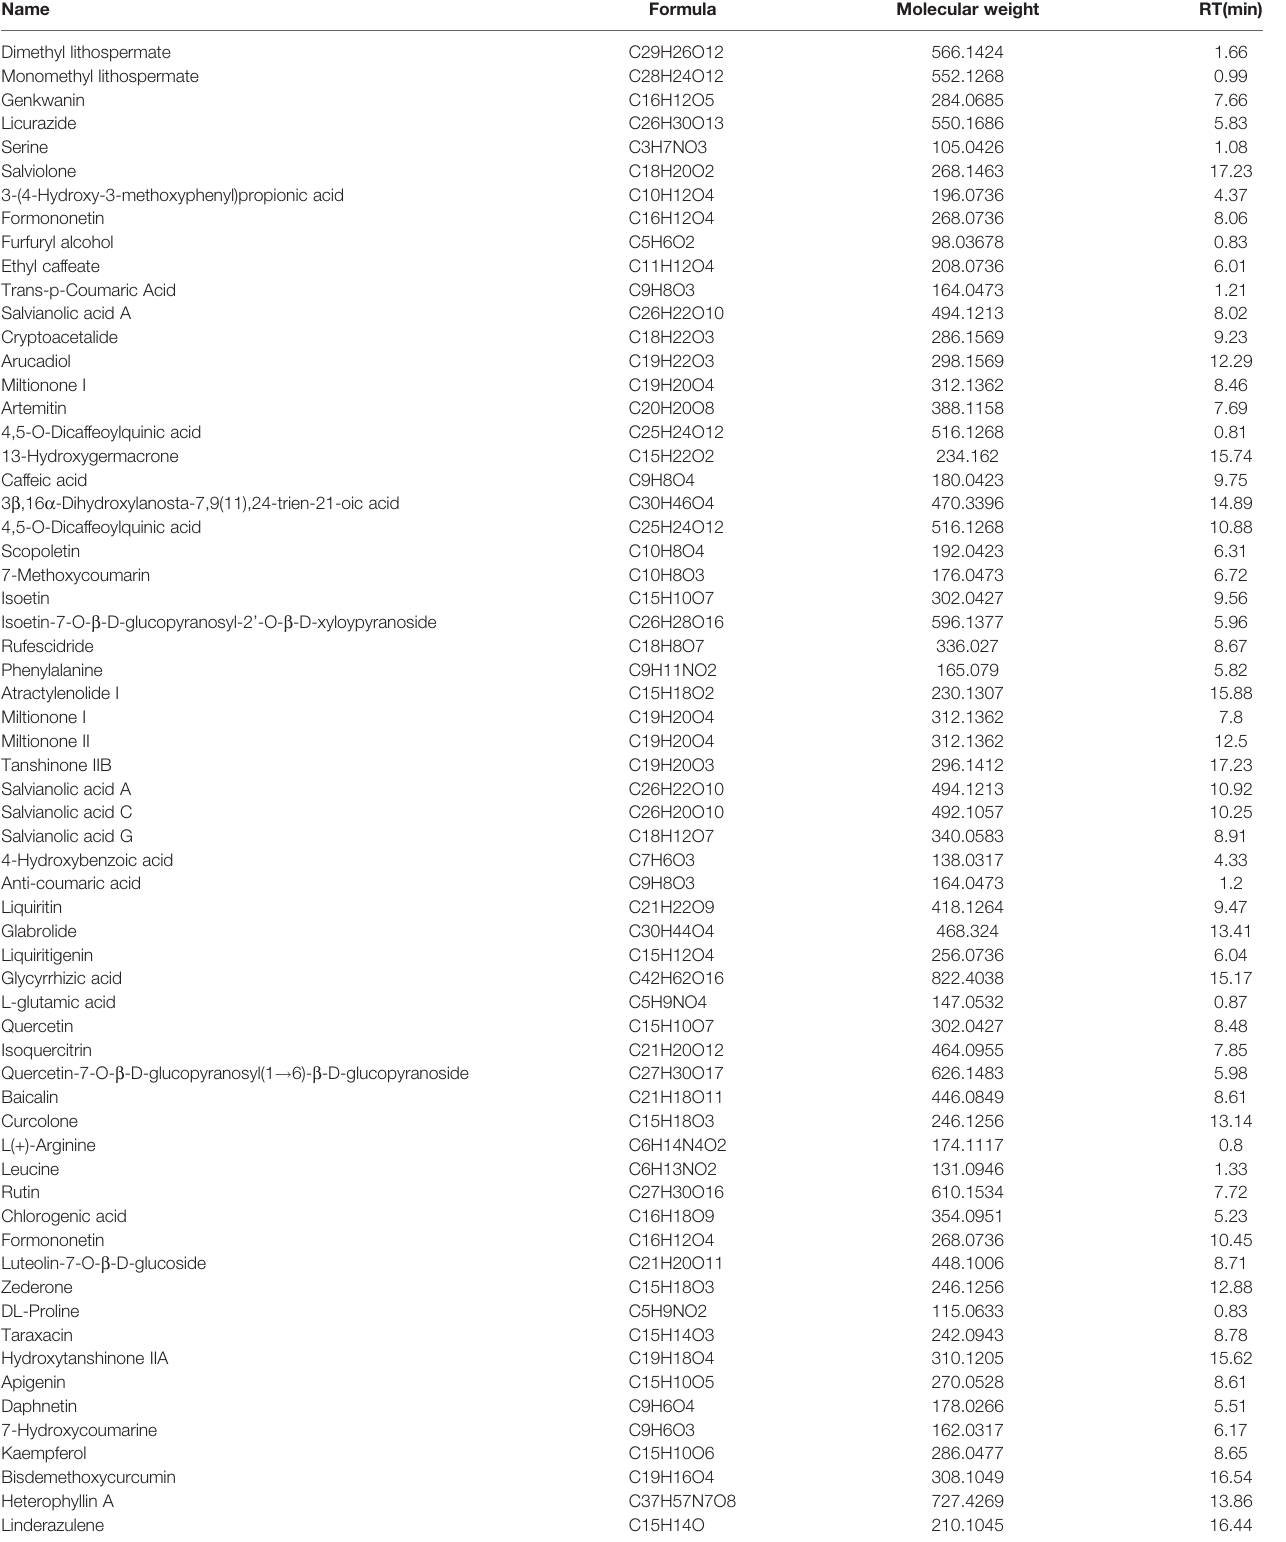
TABLE 1 | Characteristics of some chemical components in SCTWD by UPLC-Q/TOF MS analysis.